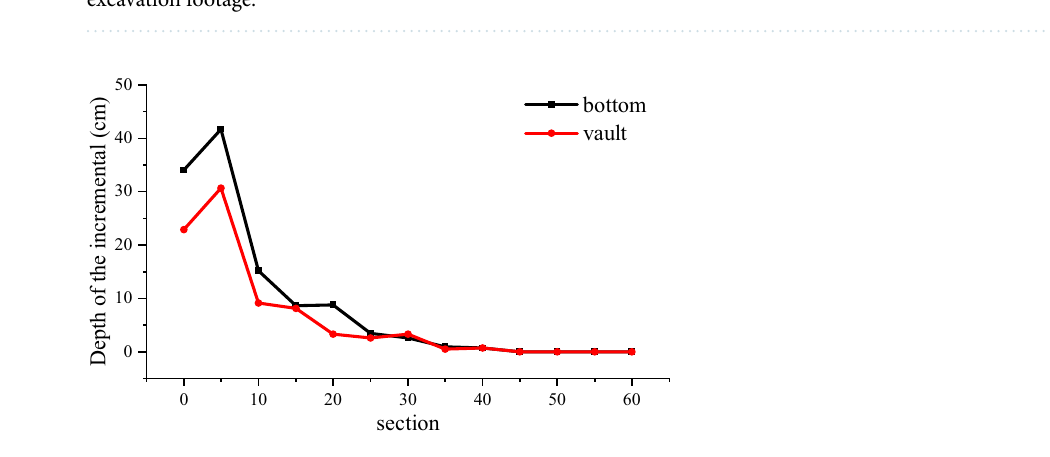
Figure 15. Damage distribution of surrounding rock in different sections of the lower step of the first excavation footage.